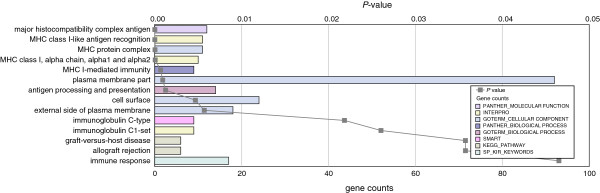
Overrepresented gene ontology categories for differentially expressed genes in the En2-/-adult cerebellum. Differentially expressed genes (n = 842) were analyzed for enrichment in gene ontology categories using DAVID with a Benjamini corrected P value cutoff of 0.05. Categories are arranged from most significant and downwards (gray line), for each category the number of genes is indicated by the length of the horizontal bars (gene counts). To highlight distinct ontological categories, bars are color-coded as indicated in the inset to the figure. Data details are also reported in Additional file 5.